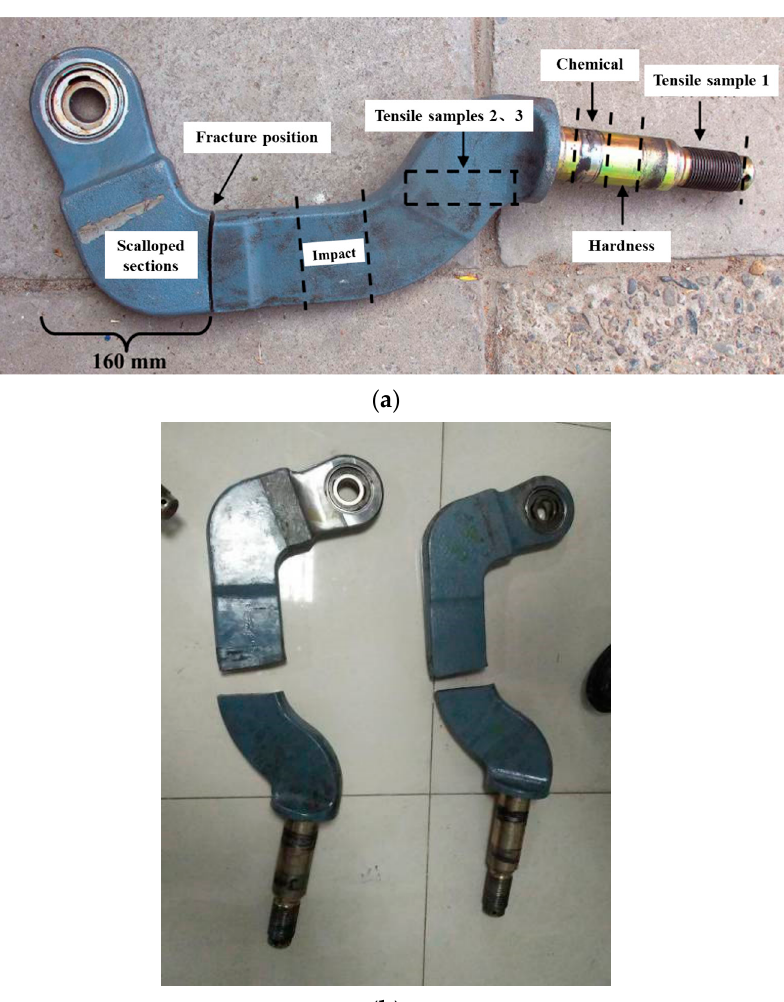
Figure 1. Appearance of booms. ( a ) Sampling areas; ( b ) Appearance of fractured booms.